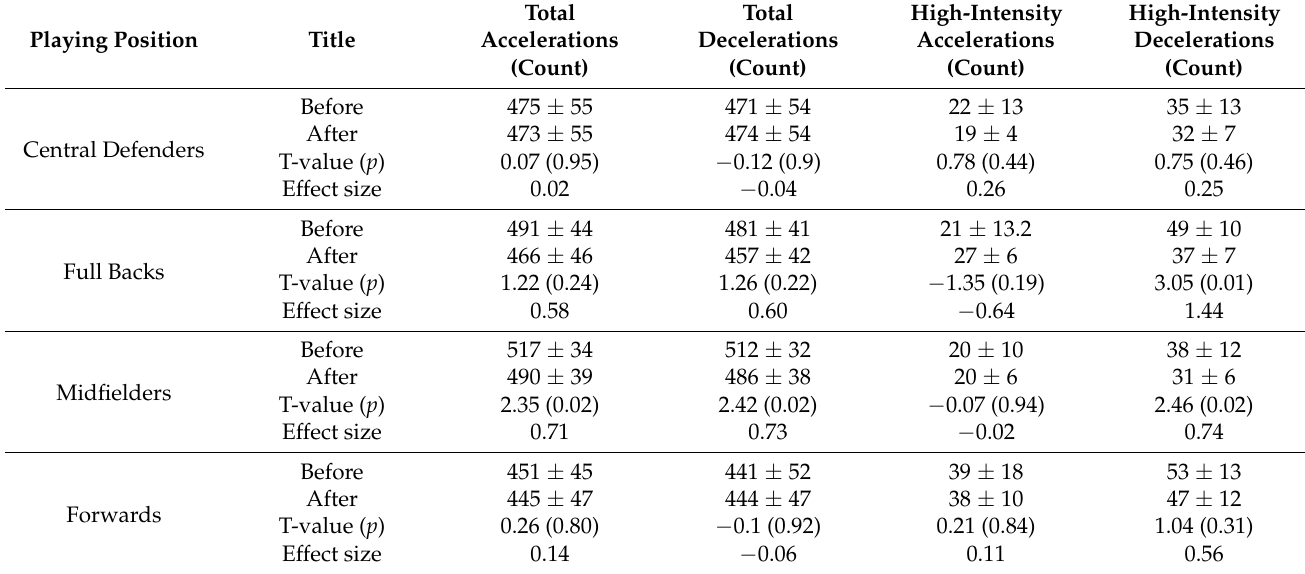
Table 2. Descriptive statistics and differences in total and high-intensity accelerations, and total and high-intensity decelerations before and after lockdown in